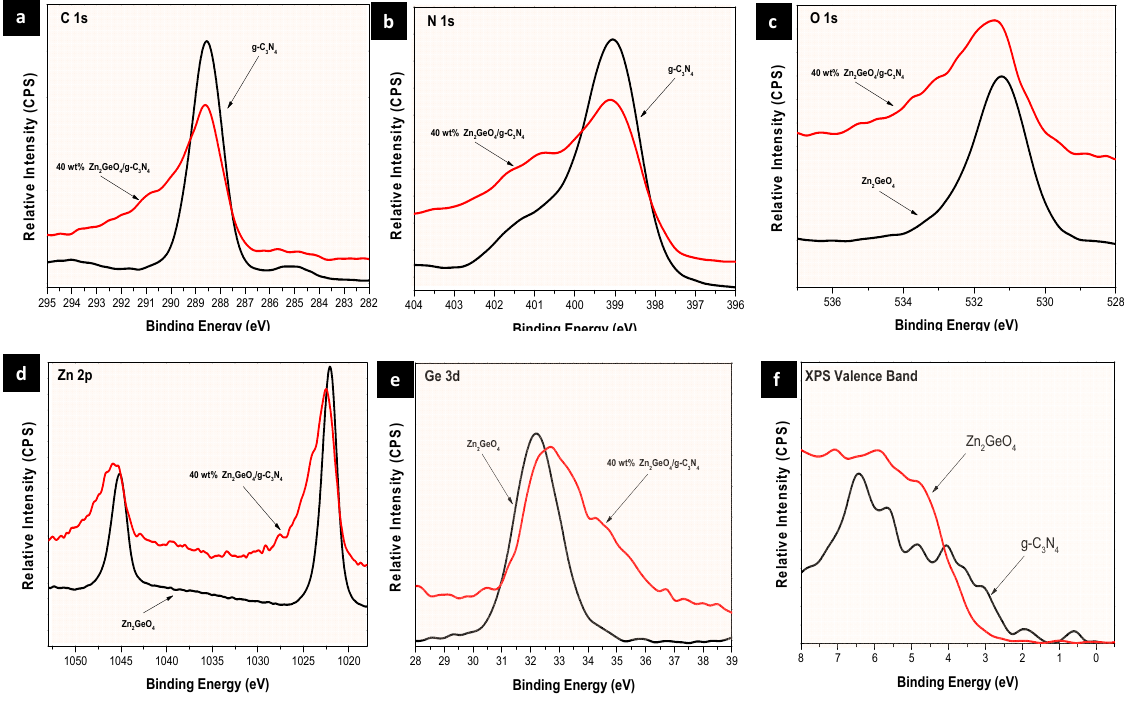
Figure 3. Representative XPS spectral windows of the reference materials and the 40 wt% of Zn 2 GeO 4 /g-C 3 N 4 nanocomposite, showing the ( a ) C 1s, ( b ) N 1s, ( c ) O 1s, ( d ) Zn 2p, and ( e ) Ge 3d lines. The valence bands window of both g-C 3 N 4 and Zn 2 GeO 4 samples ( f ), as indicated. Note that the composite lines are subject to differential charging, due to which asymmetric broadening tails are